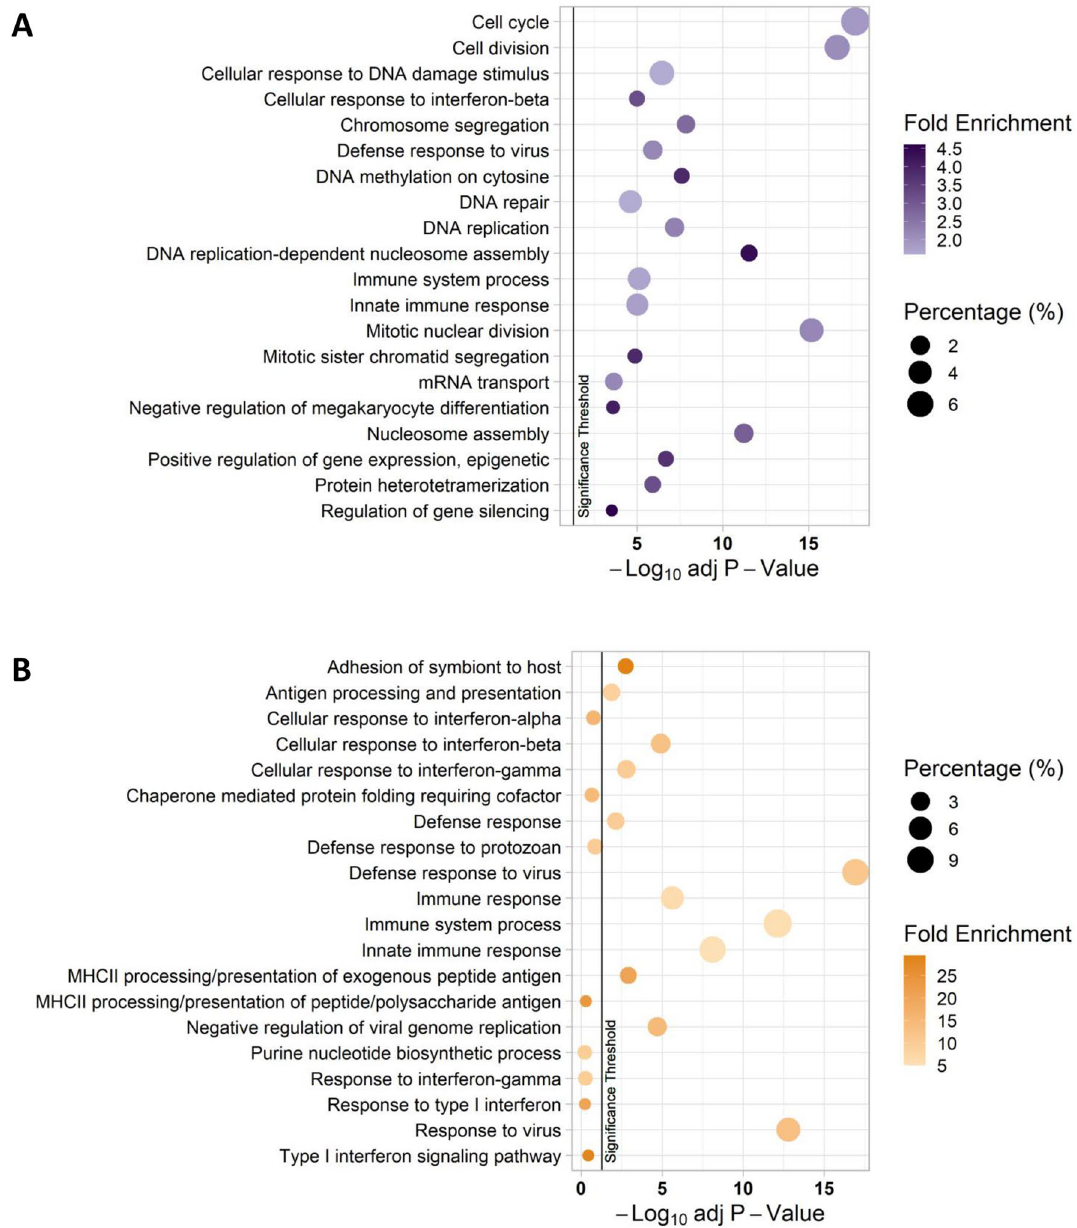
Figure 2. The 20 most siginificantly changed biological pathways in the Spi1 knock-down ( A ) and Spi1 over-expression ( B ) datasets assessed using DAVID. In these graphs the Benjamini–Hochberg adjusted p value(− Log 10 ) is displayed on the x-axis, the Gene Ontology (GO) term listed on the y-axis, the percentage of the gene list in each cluster is denoted by the size of the bubble and the colour denotes the fold-change, where a darker colour indicates a stronger enrichment. The vertical black line indicates the p value cut-off of 0.05. Bubble plots were made using the ‘tidyverse’ 37 and ‘ggpubr’ 38 packages in R 39,40